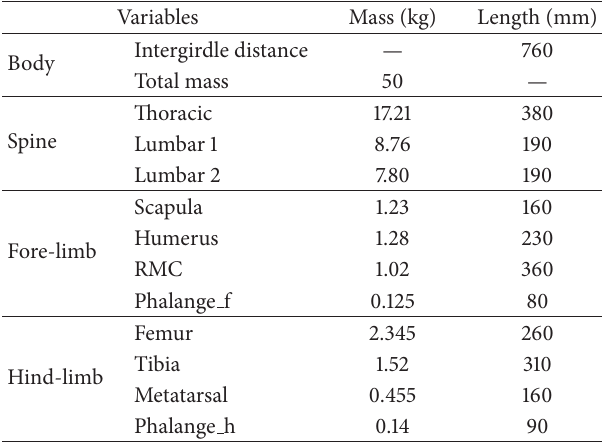
Table 1: Mechanical parameters of cheetah.